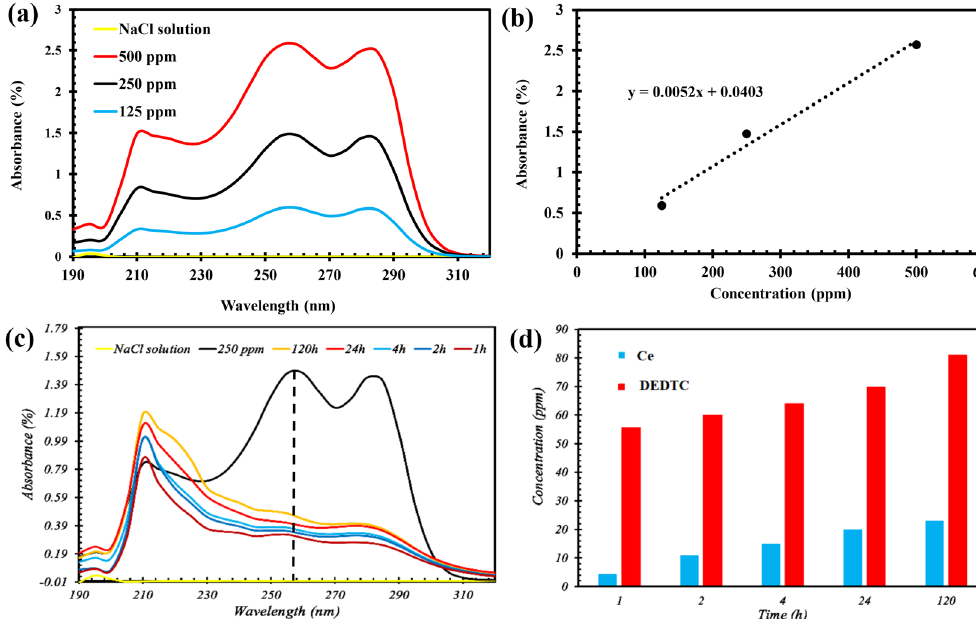
Figure 4. The UV-vis spectra of the 3.5 wt.% NaCl electrolyte, different concentration of the DEDTC and extract solution of the Ce-DEDTC pigment at different dissolution times: ( a ) UV-vis spectra of the 3.5 wt.% NaCl solution at difference concentration of the DEDTC, ( b ) linear regression curve of the DEDTC concentration vs UV-vis absorbance peak at ca. 260 nm extracted from the part ( a , c ) UV-vis spectra of the Ce- DEDTC extract solution, and ( d ) the amount on the released DEDTC (measured from the UV-vis result) and Ce (measured by ICP-OES test) from the structure of the Ce-DEDTC